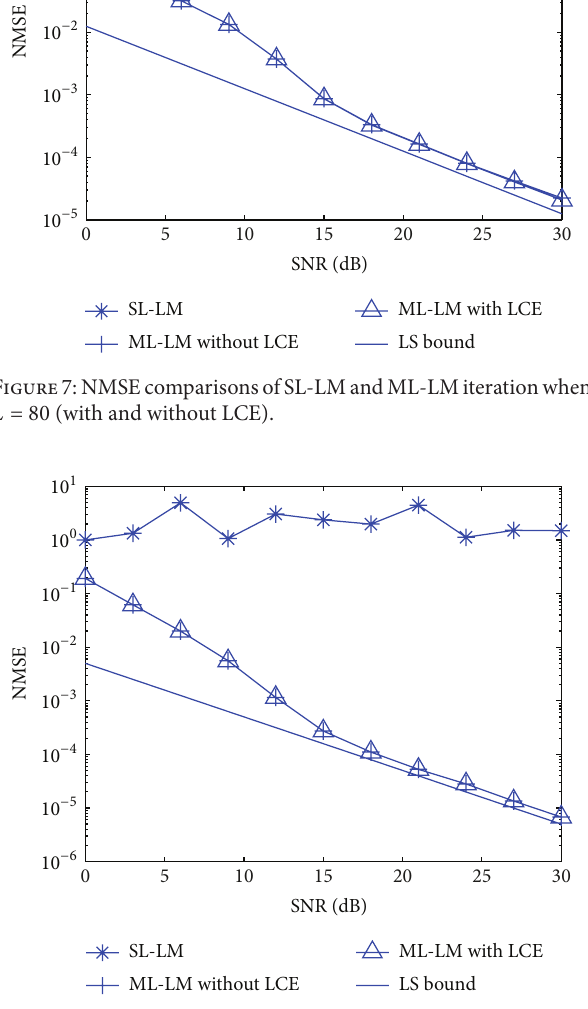
Figure6:NMSEcomparisonsofSL-LMandML-LMiterationwhen 𝐿 = 40 (with and without LCE).